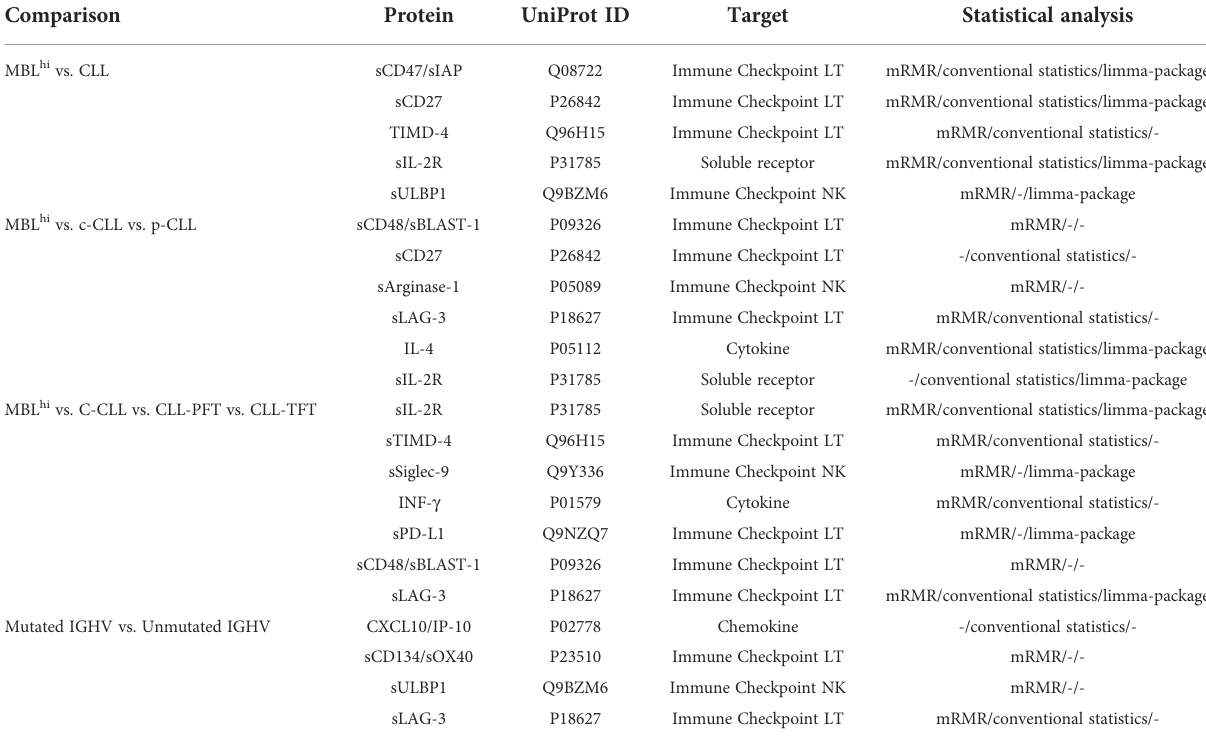
TABLE 3 List of relevant soluble immune factors according to stage and evolution disease.